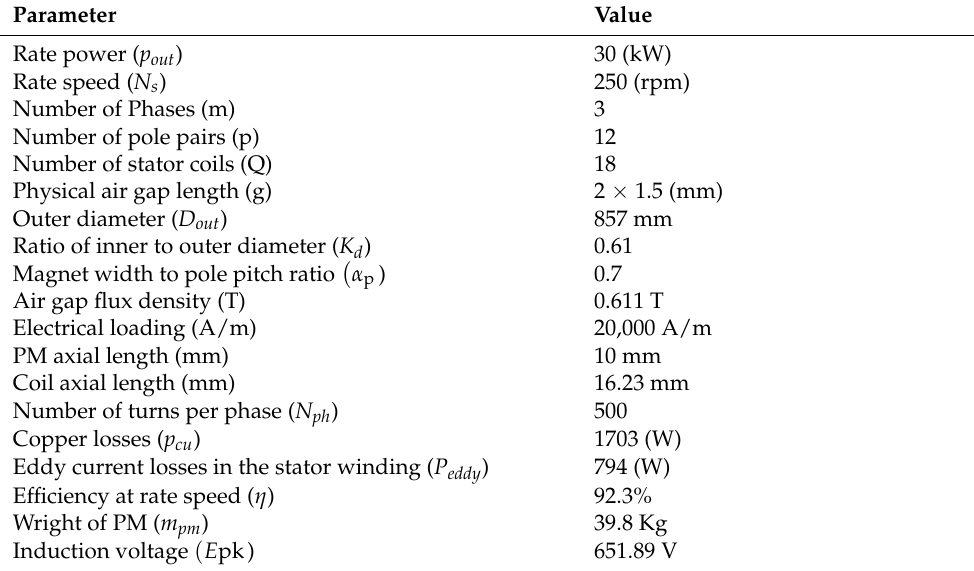
Table 5. Final Design Parameters of the Ironless AFPMWG.